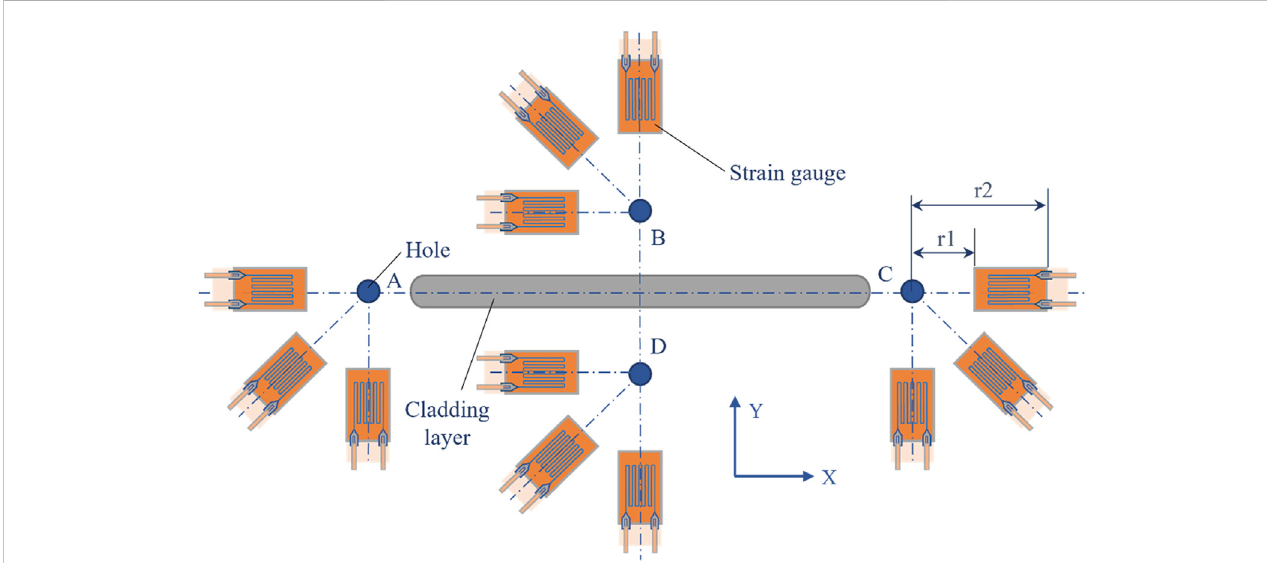
FIGURE 3 Schematic diagram of residual stress test.